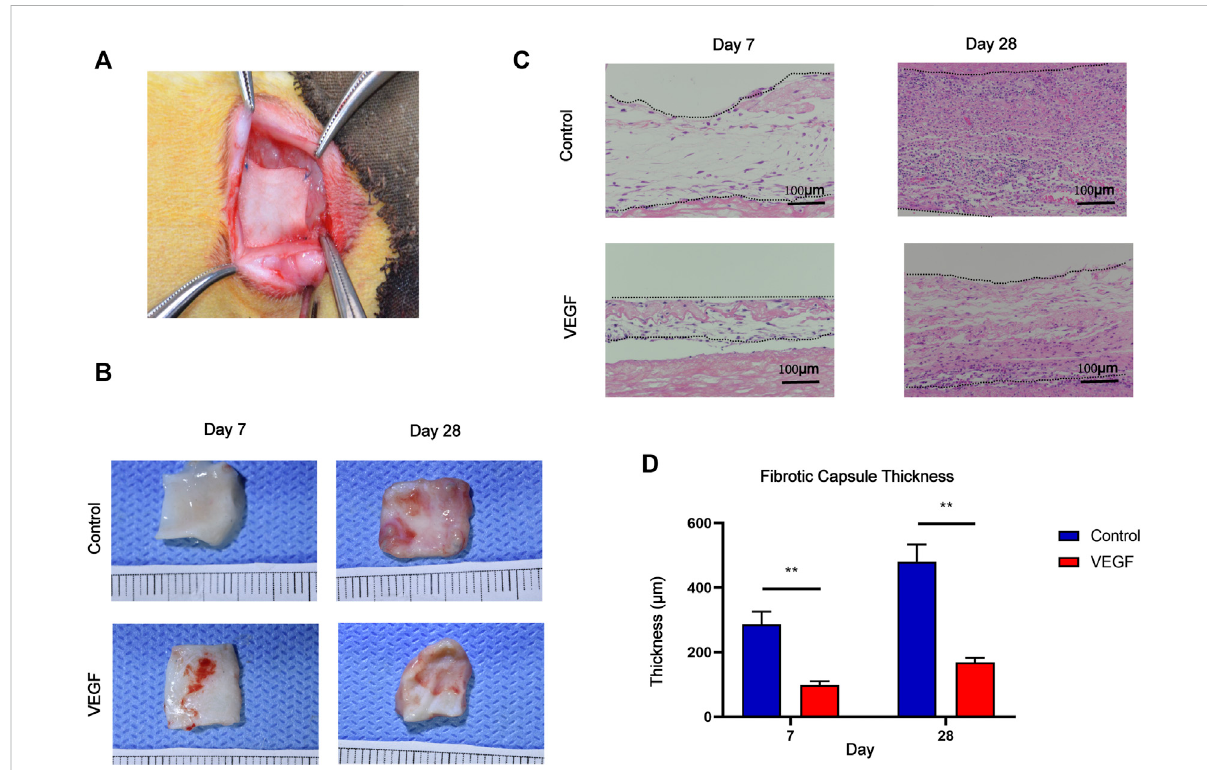
FIGURE 5 Macroscopicimagesoftherabbitsubcutaneousimplantationmodel (A) .Grossimagesofsubcutaneousimplantsatdays7and28ineachgroup (B) .HEstainingofsubcutaneousimplantsatdays7and28ineachgroup. Betweenthetwodashedlinesdepictsthe fi brouscapsuleofsubcutaneous implants (C) . Measurement of fi brous capsule thickness (D) . * p < 0.05. ** p < 0.01. ns represents no signi fi cant